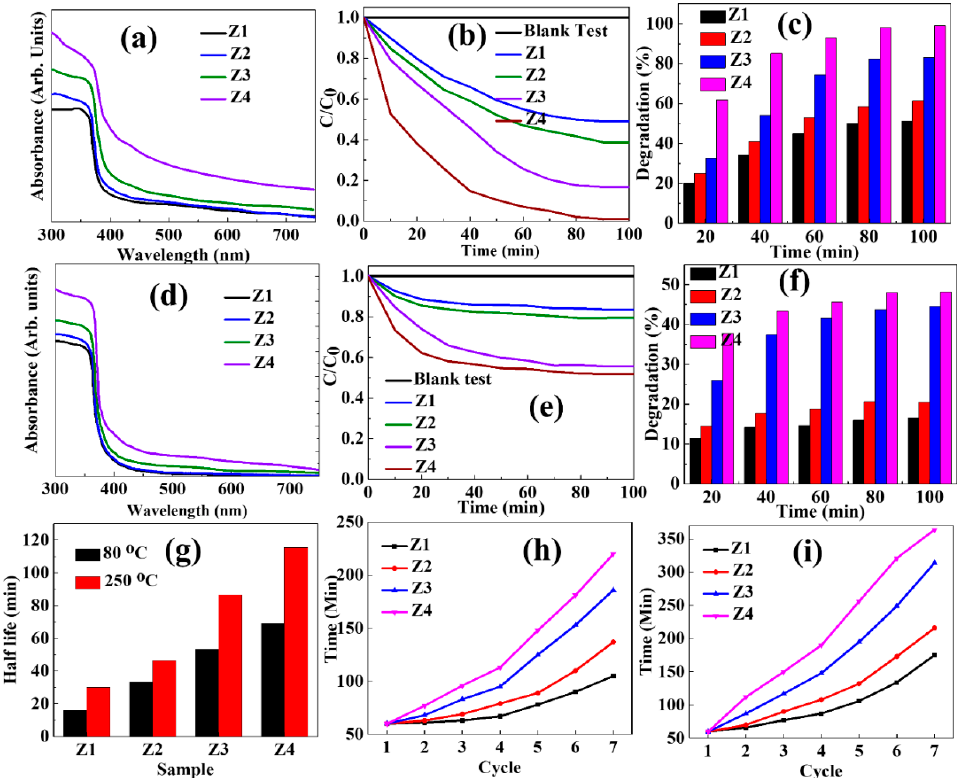
Figure 7. ( a )–( c ) shows the absorbance spectra, photocatalytic activities, and percentage dye degradation, respectively for synthesized ZnO dried at 80 °C; ( d )–( f ) shows the absorbance spectra, photocatalytic activities and percentage dye degradation, respectively with synthesized ZnO dried at 250 ◦